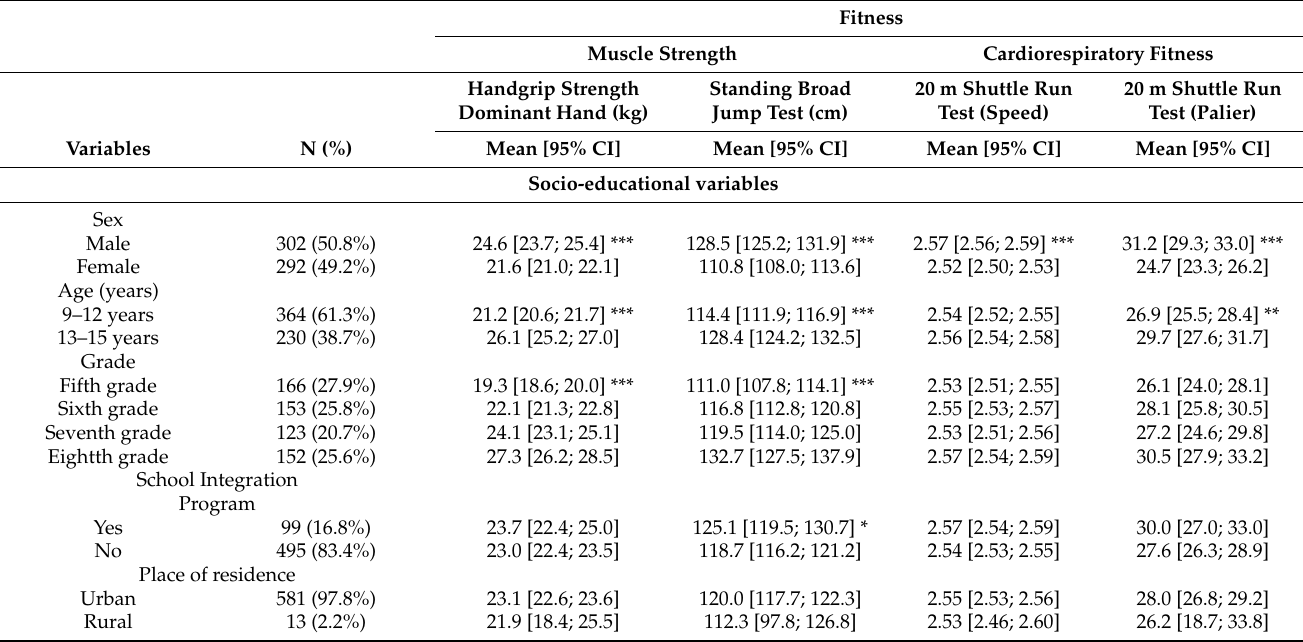
Table 1. Physical fitness according to socio-educational characteristics and lifestyle.